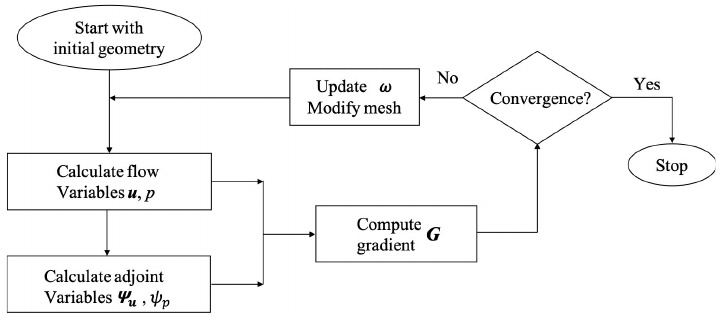
Figure 7. Optimization procedure.